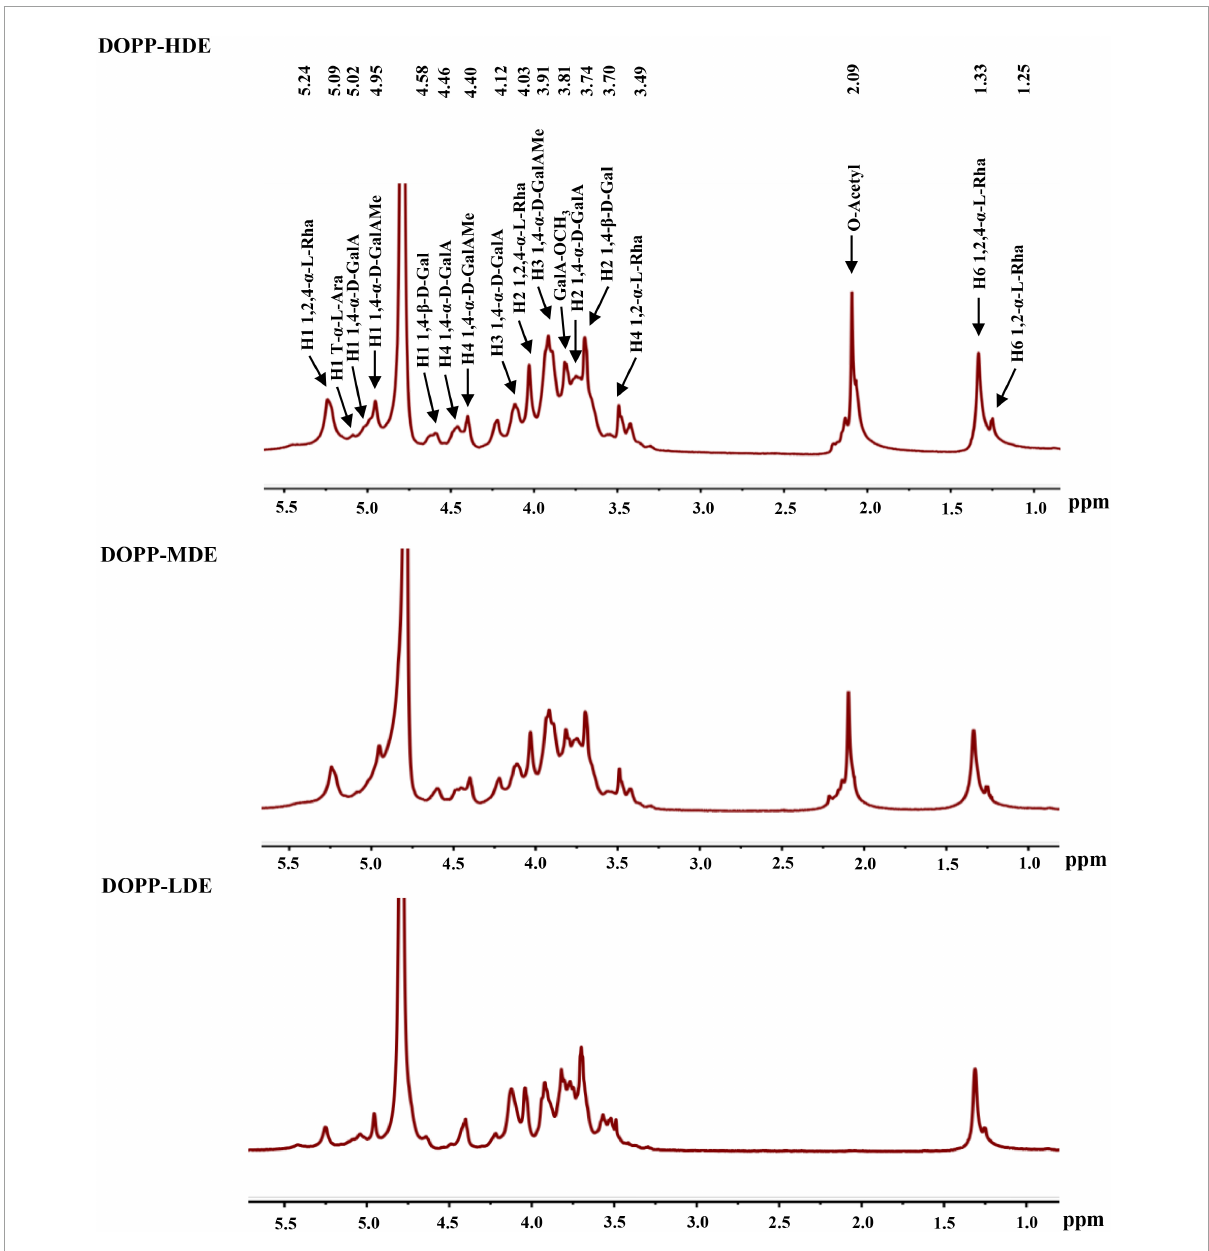
FIGURE2 1 H NMR spectra of okra pectic-polysaccharides (OPP) with various degrees of esterification. The sample codes were the same in Figure 1 .